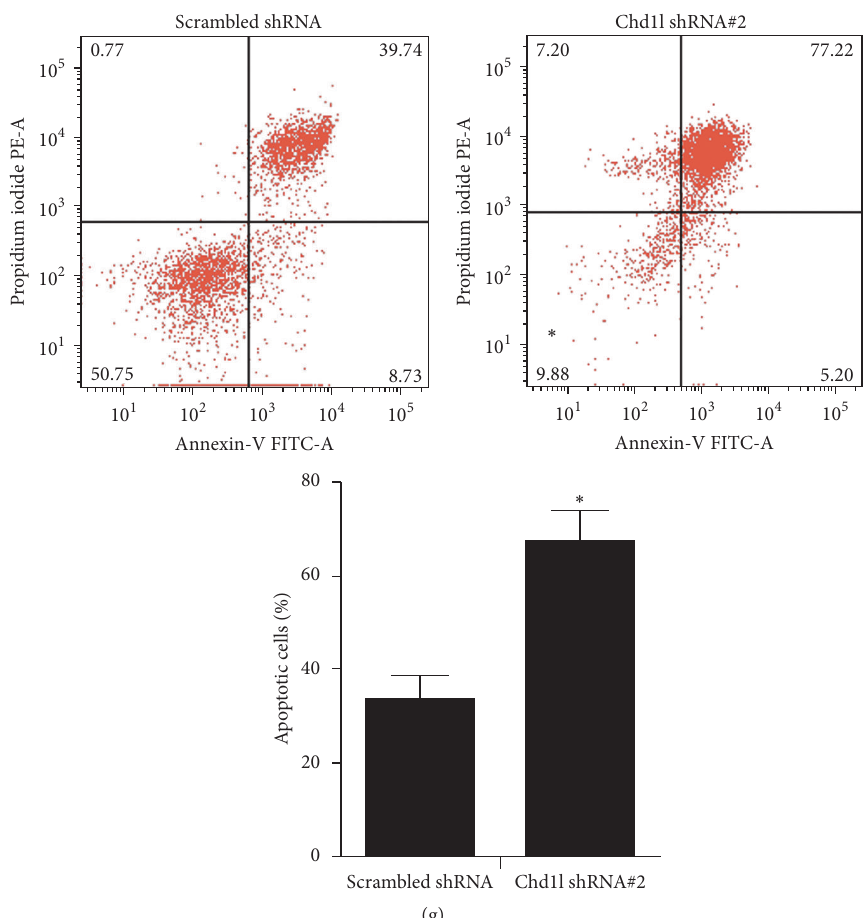
Figure4:Chd1lmodulatesSSCgeneexpression,clonogenicity,proliferation,andapoptosis.(a) Chd1l